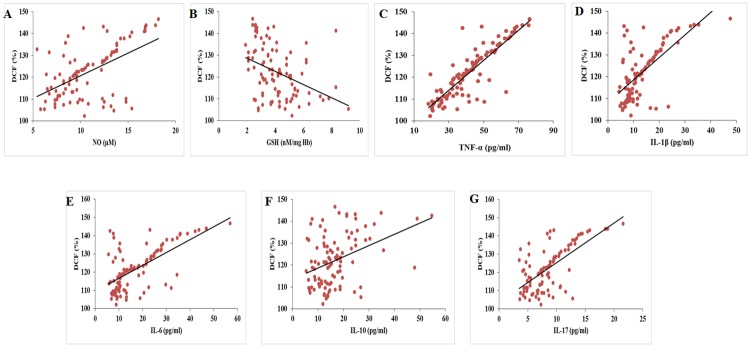
Correlation between ROS and NO (Fig A), GSH (Fig B), TNF-α (Fig C), IL-1β (Fig D), IL-6 (Fig E), IL-10 (Fig F) and IL-17 (Fig G).